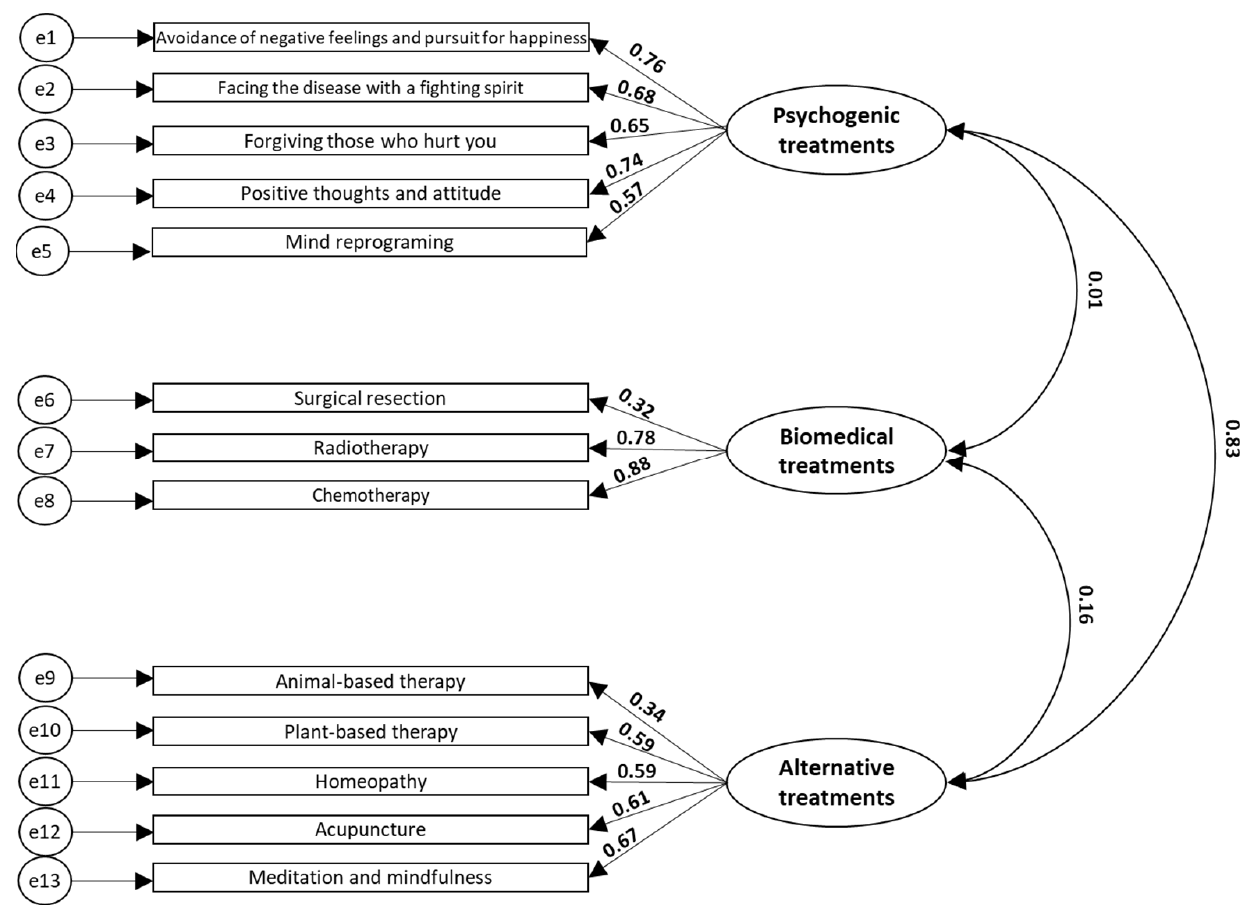
Figure 2. Explanatory model of the attributions to the treatment efficacy of cancer. The regression coefficients between the items (rectangles) with the constructs (ovals) and between the three constructs are shown. All data have p -values < 0.001. NFI 0.836, IFI 0.869, TLI 0.833, CFI 0.867, and RMSEA 0.092.